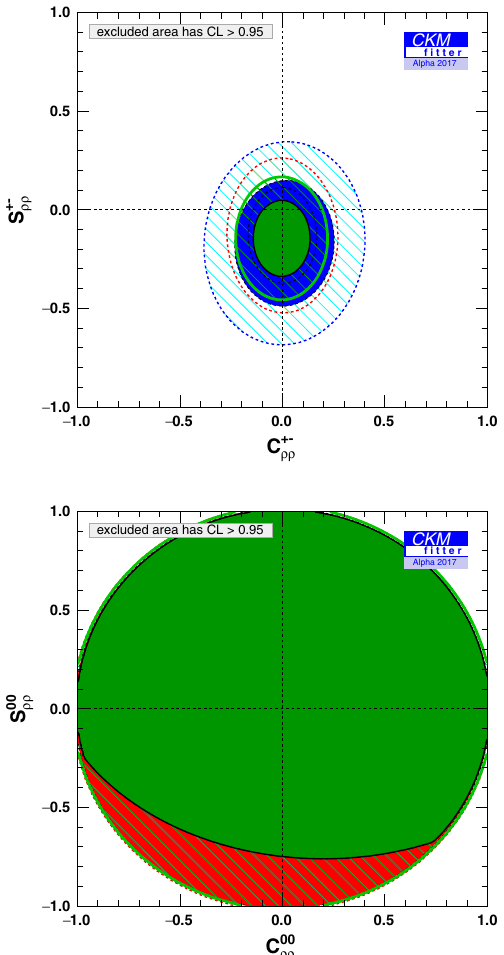
Fig. 45 Measurements of the B → ρρ CP asymmetries from BaBar ( blue area ) and Belle ( red area ). The LHCb contribution to the B → ρ 0 ρ 0 branching fraction is indicated by the orange area . The green shaded area represents the world average